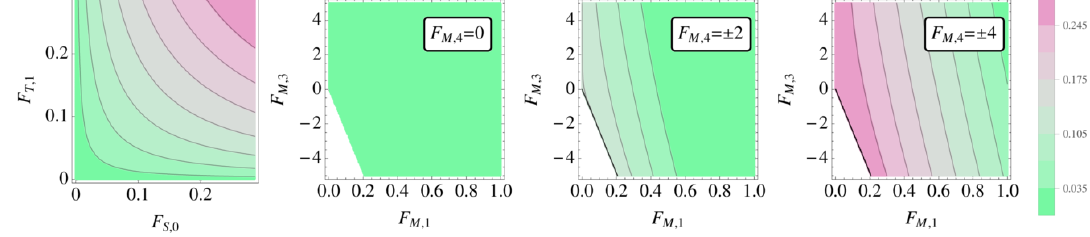
Figure 19 . Similar to (cid:12)gure 18, but for the quartic inequality from the WZ channel, in the subspace of F S; 0 , F T; 1 , F M; 1 and F M; 3 , with di(cid:11)erent values of F M; 4